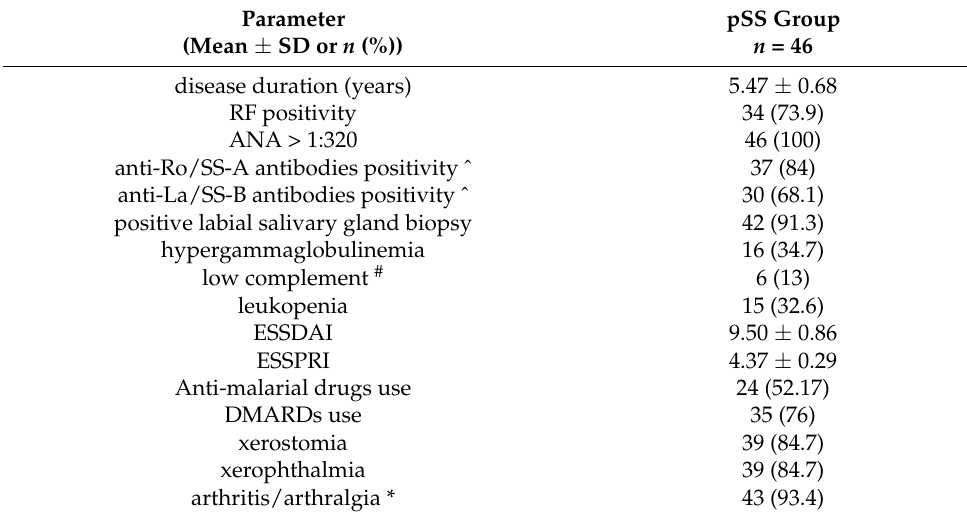
Table 1. Detailed characteristics of the pSS